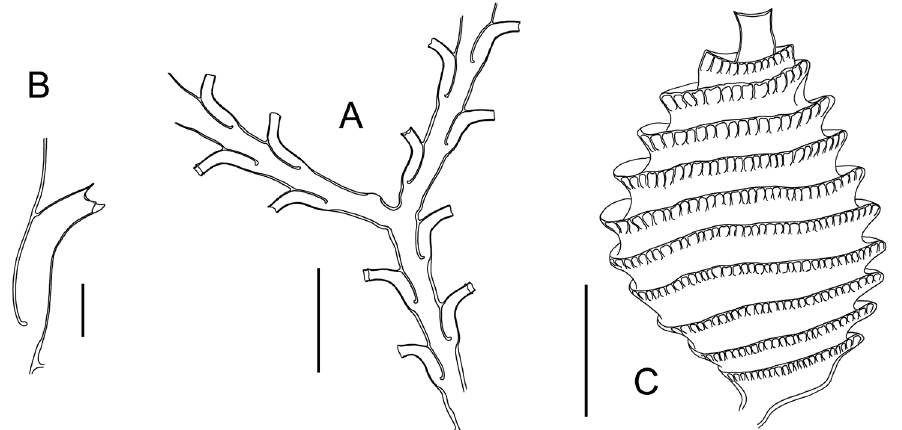
Fig. 15. Dictyocladium reticulatim (Kirchenpauer, 1884). A–C . Colony fragment (A), hydrotheca (B), gonotheca (C), all from sample MNHN-IK-2015-405. Scale bars: A = 1 mm; B = 200 µm; C = 500